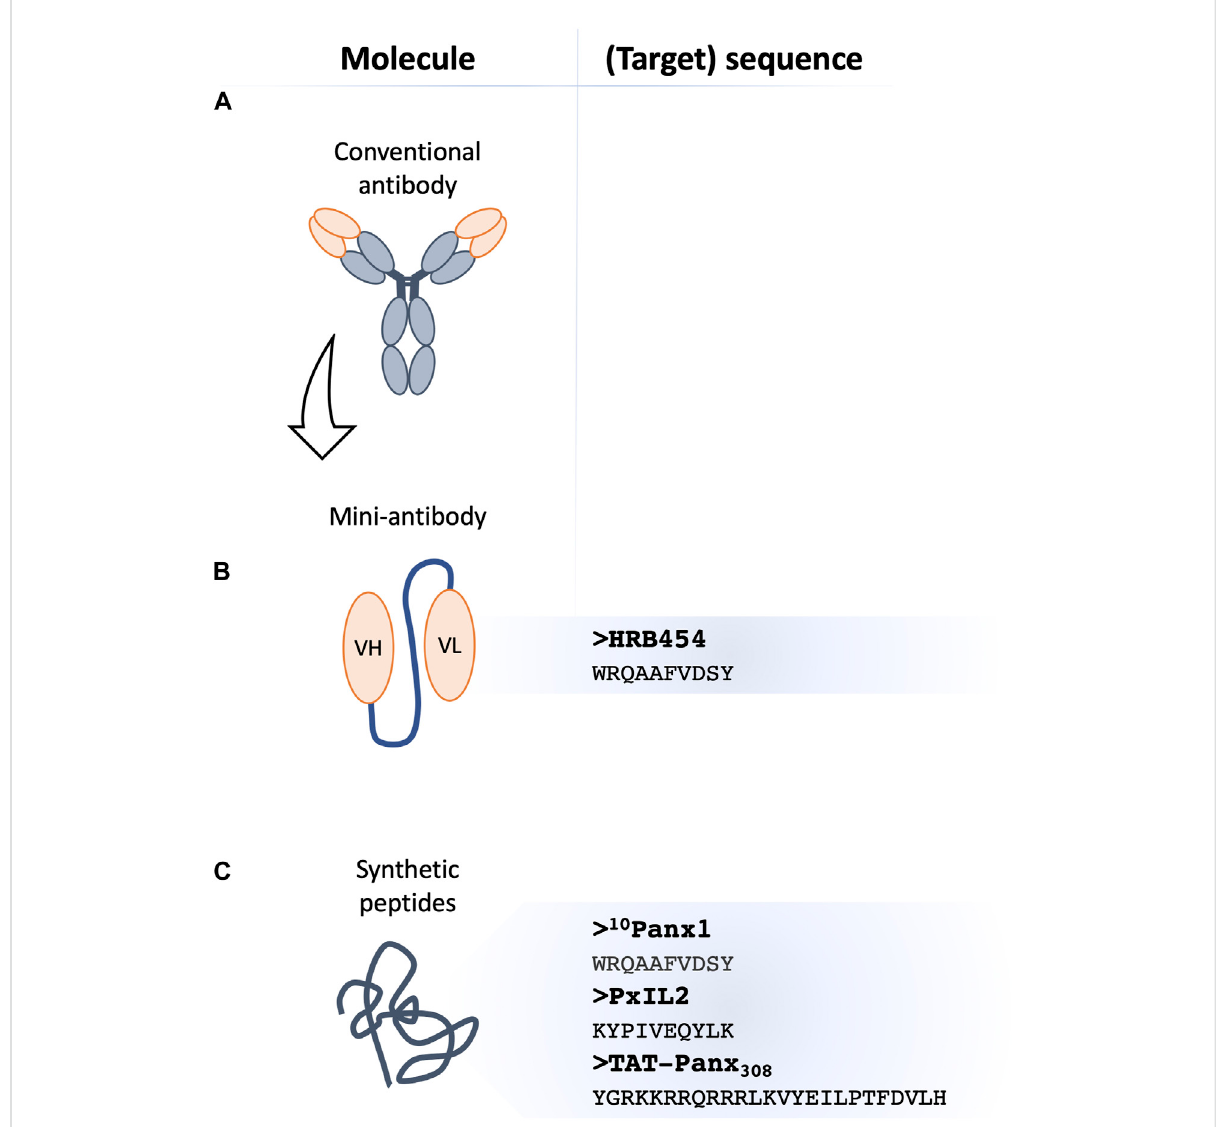
FIGURE 2 Novel classes of Panx1 channel inhibitors. Membrane channel inhibitors comprise antibody-based strategies, where conventional monoclonal antibodies (A) with a channel blocking capacity appear as an attractive tool in biotechnology. The single variable fragment (scFv)-based agents known as ‘ mini-antibodies ’ exhibit better tissue penetration and fewer adverse effects due to their reduced size. The scFv-based against Panx1 (B) , referred to as HRB454, with its target sequence is shown at the right. Mimetic peptides (C) have all sequence homology to Panx1 and their blocking capacitycan bebased on interference with Panx1 phosphorylationbyproviding an additional substrate to a kinase(e.g.,TAT-Panx 308 )or by disturbing (other) protein-protein interactions (e.g., 10 Panx1 and PxIL2). PxIL2 and TAT-Panx 308 peptides target intracellular Panx1 domains, thus TAT-conjugation or inclusion in patch pipette solution will allow for optimal ef fi cacy. The published sequences of peptide-based inhibitors are shown on the